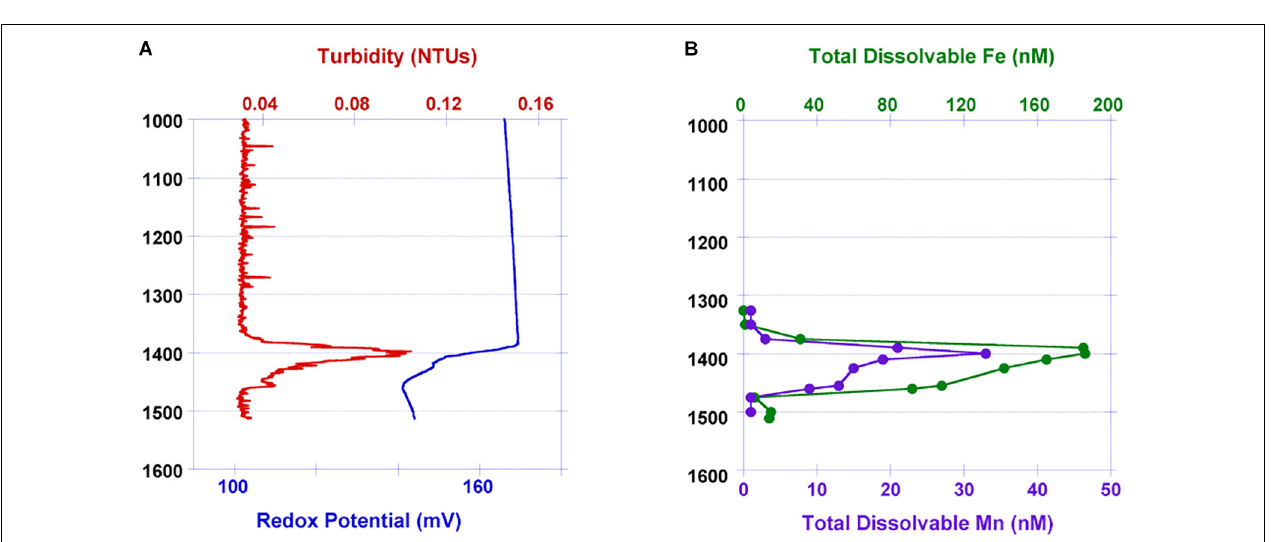
FIGURE 5 | Vertical profiles for (A) Turbidity (NTUs; Seapoint Turbidity Meter) and Redox Potential (mV; NOAA-PMEL Oxidation Reduction Probe) and (B) Total Dissolvable Fe and Total Dissolvable Mn concentrations from the deep portion ( > 1000 m) of US GEOTRACES CTD Station